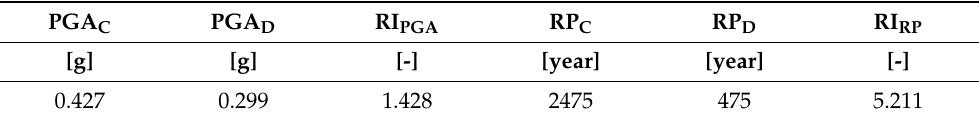
Table 6. Risk indices obtained from pushover analysis (retrofitted configuration).